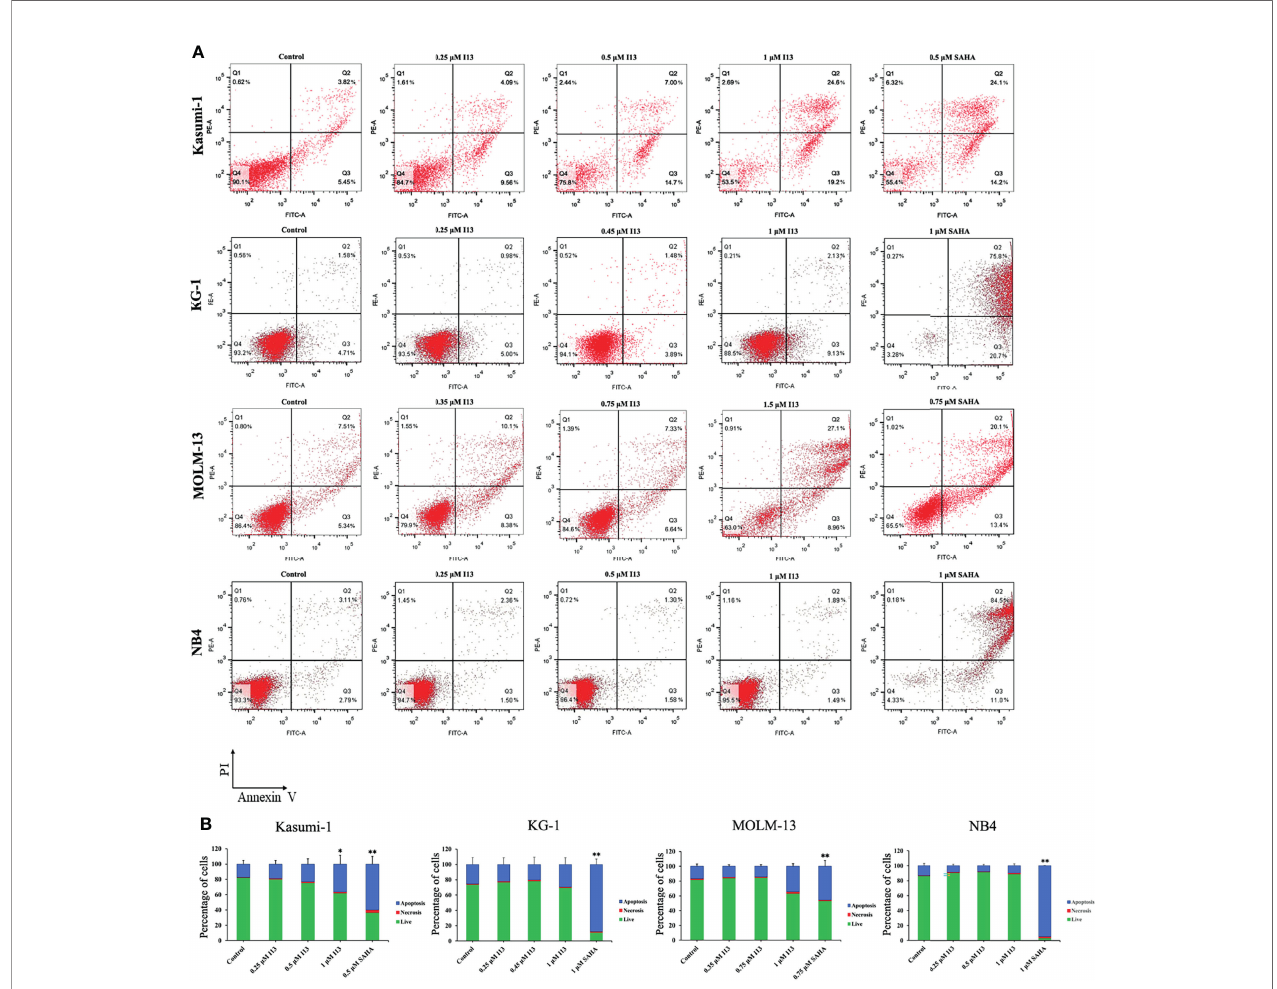
FIGURE 4 | I13 reduced less apoptosis of Kasumi-1, KG-1, MOLM-13 and NB4 cells. (A) Kasumi-1, KG-1, MOLM-13 and NB4 cells were treated with I13 (0.25- 1.5 µM) or SAHA (0.5, 0.75 or 1 µM) for 72 h. Cells were then stained with Annexin V-FITC/PI and detected by fl ow cytometry. (B) A bar graph showing the statistical analysis of apoptosis (*p < 0.05 and **p < 0.01). The analysis was carried out three